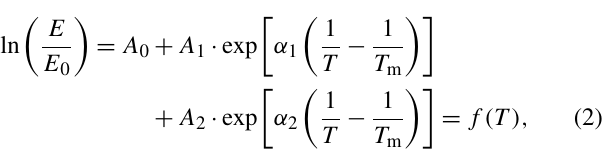
Figure 9. Same legend as Fig. 6, for snowmelt event 1